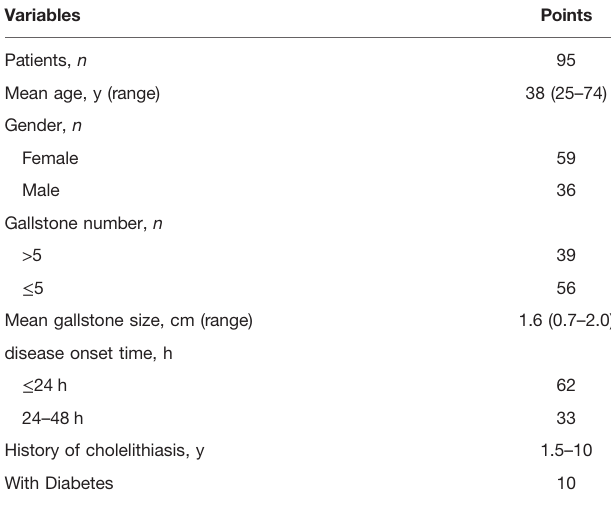
TABLE 1 | Statistical analysis of general information of patients.